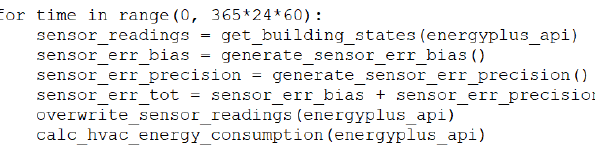
Figure 2. Pseudo code for sensor fault injection and simulation.